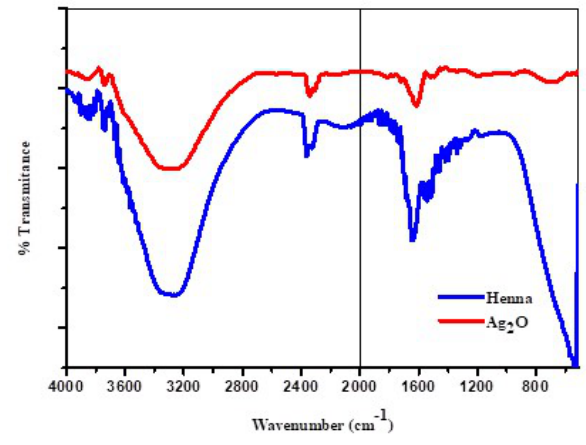
Figure 5: FTIR spectra of Ag 2 O NPs and henna plant